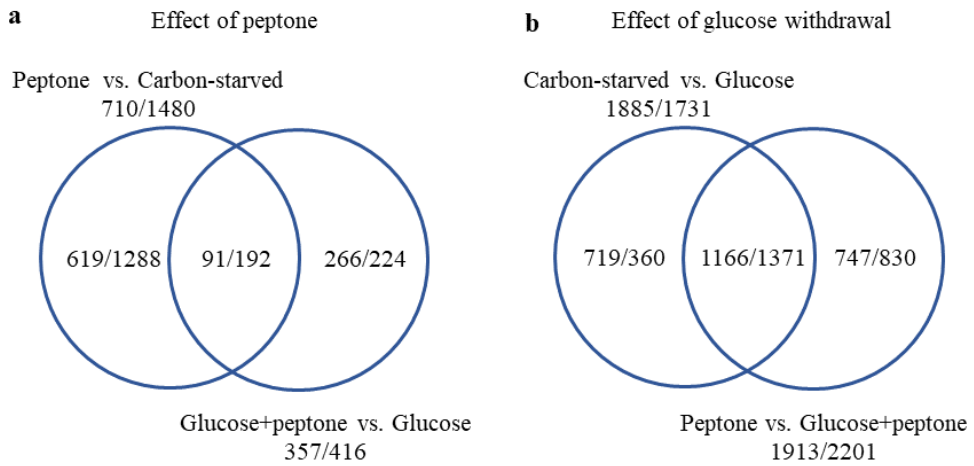
Figure 5. Distribution of genes upregulated and downregulated in the presence of peptone ( a ) or in the absence of glucose ( b ).